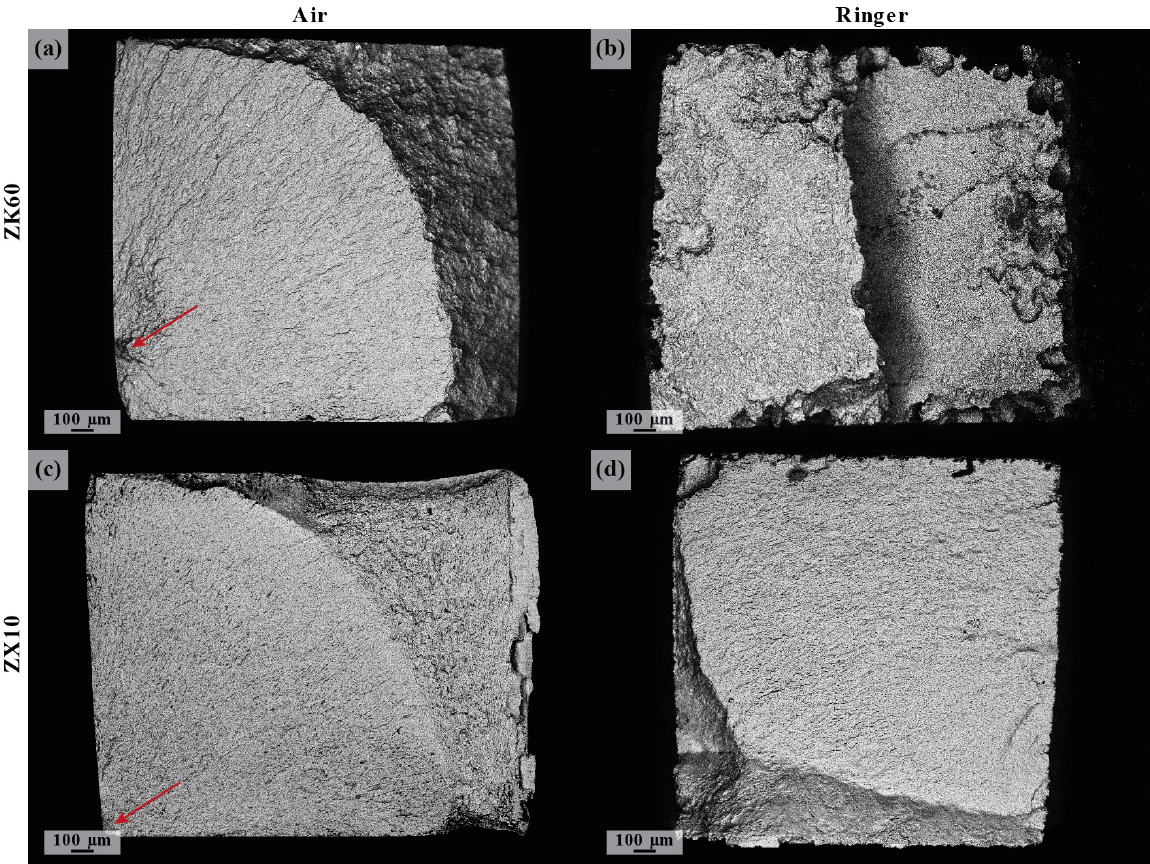
Figure 12. SEM images of the fracture surface after testing ZK60 ( a , b ) and ZX10 ( c , d ) in air ( a , c ) and in Ringer’s solution ( b , d ); the stress amplitudes are 140 MPa ( a ), 50 MPa ( b ), 90 MPa ( c ), and 60 MPa ( d ). The crack initiation site ( a , c ) is pointed to by a red arrow.